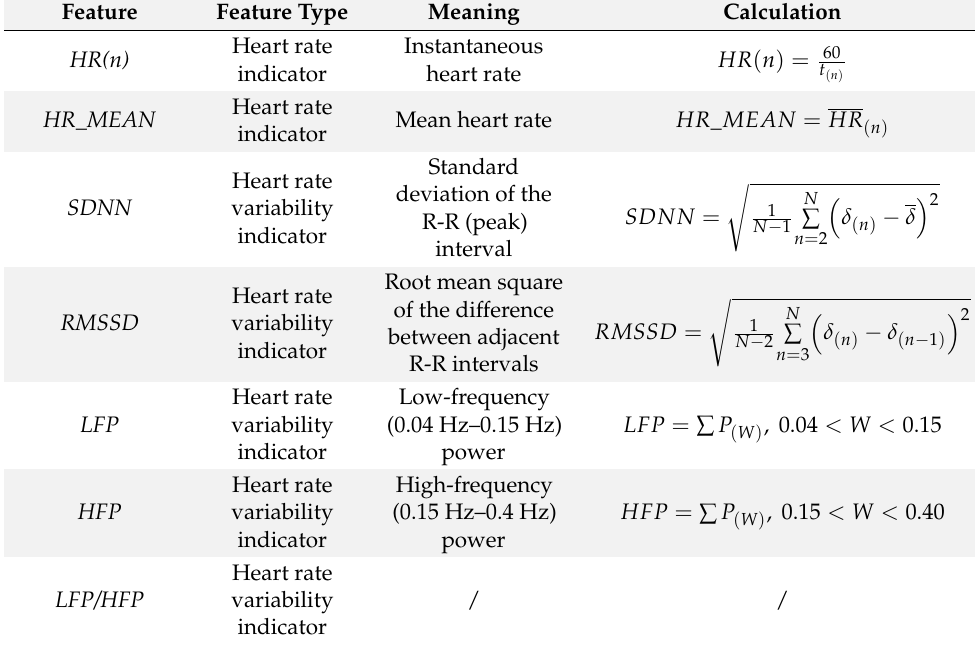
Heart rate variability / / indicator As vigilance declined, SDNN , LFP , and LFP/HFP considerably increased, HFP also noticeably decreased, and all showed significant linearities. Hence, we chose SDNN from among the above indicators, which we used as